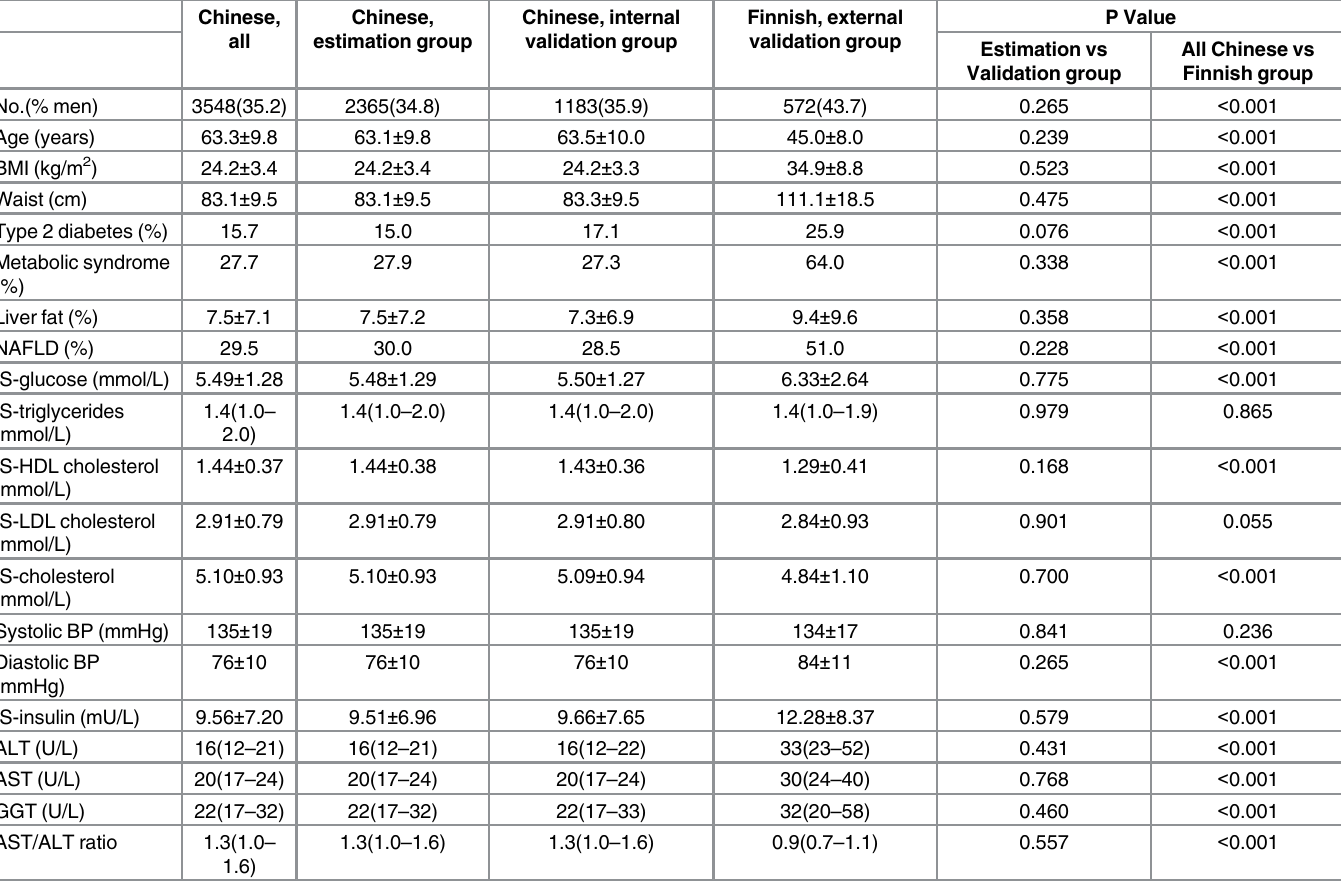
Table 1. Characteristics of the Chinese population and the Finnish external validation group. Chinese, all